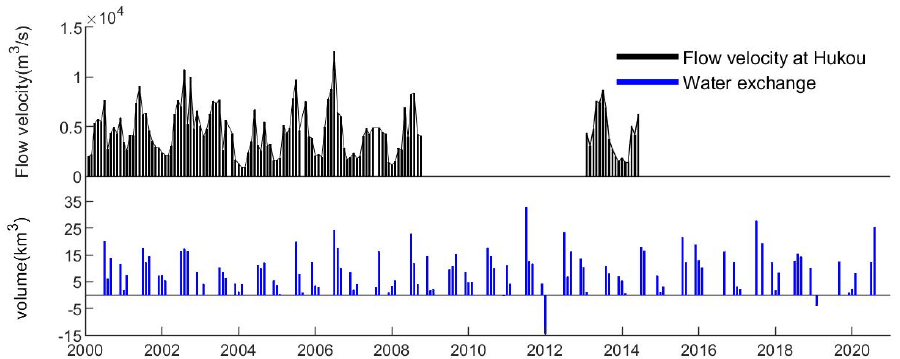
Figure 14. Gauged observations of the flow velocities (2000–2008, 2013–2014) at Hukou station and water exchanges between Poyang Lake and Yangtze River (2000–2020).